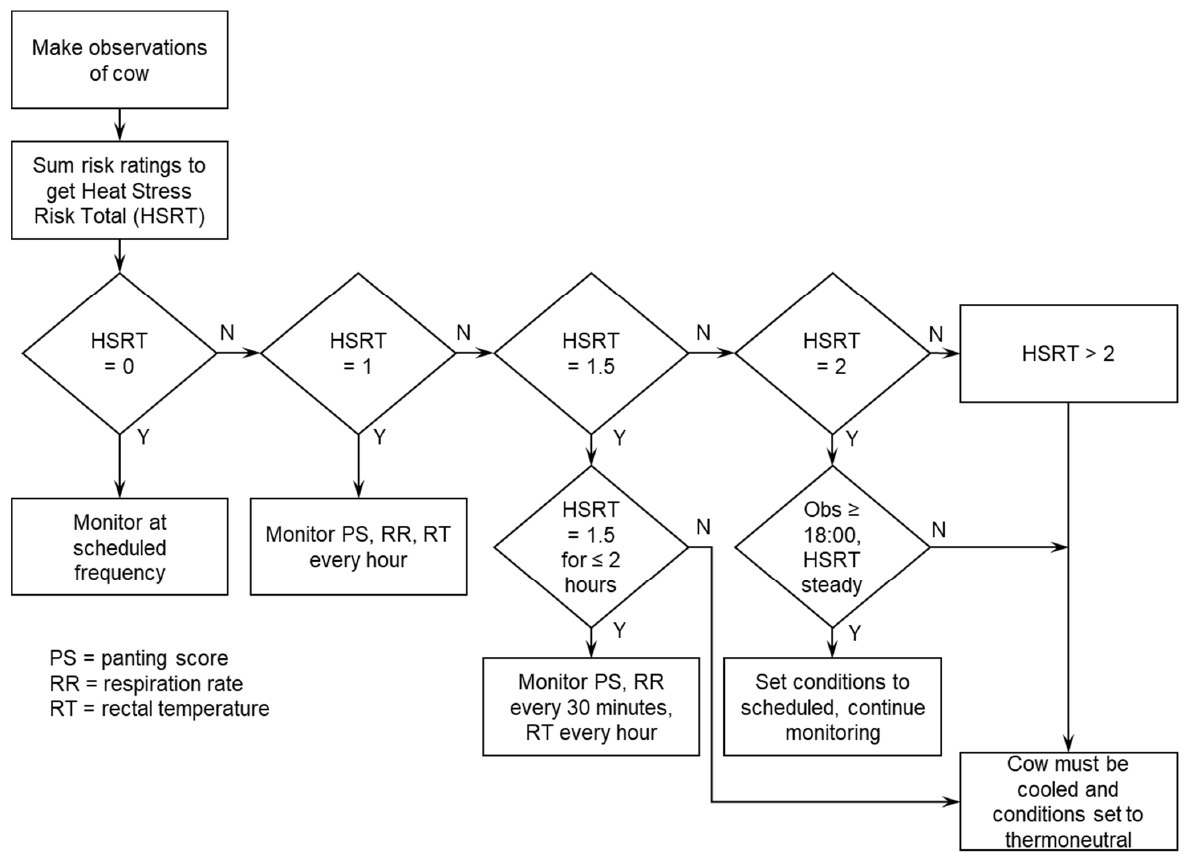
Figure 1. Flowchart of actions taken depending on the heat-stress risk total (HSRT) of the